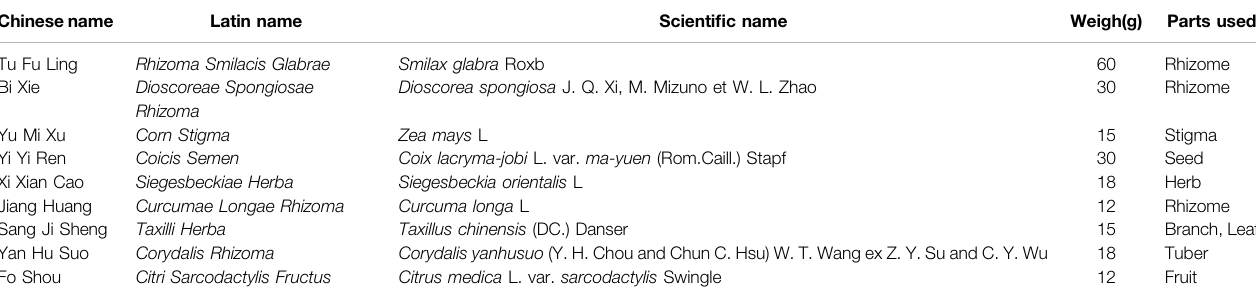
TABLE 1 | The compositions of Qu-zhuo-tong-bi decoction